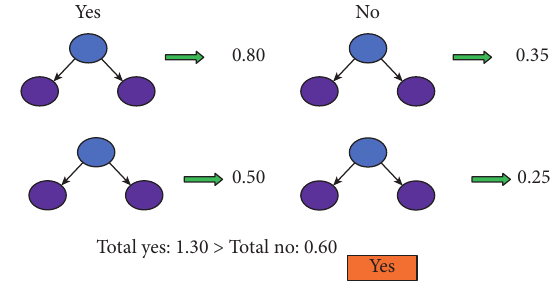
Figure 5: Example of